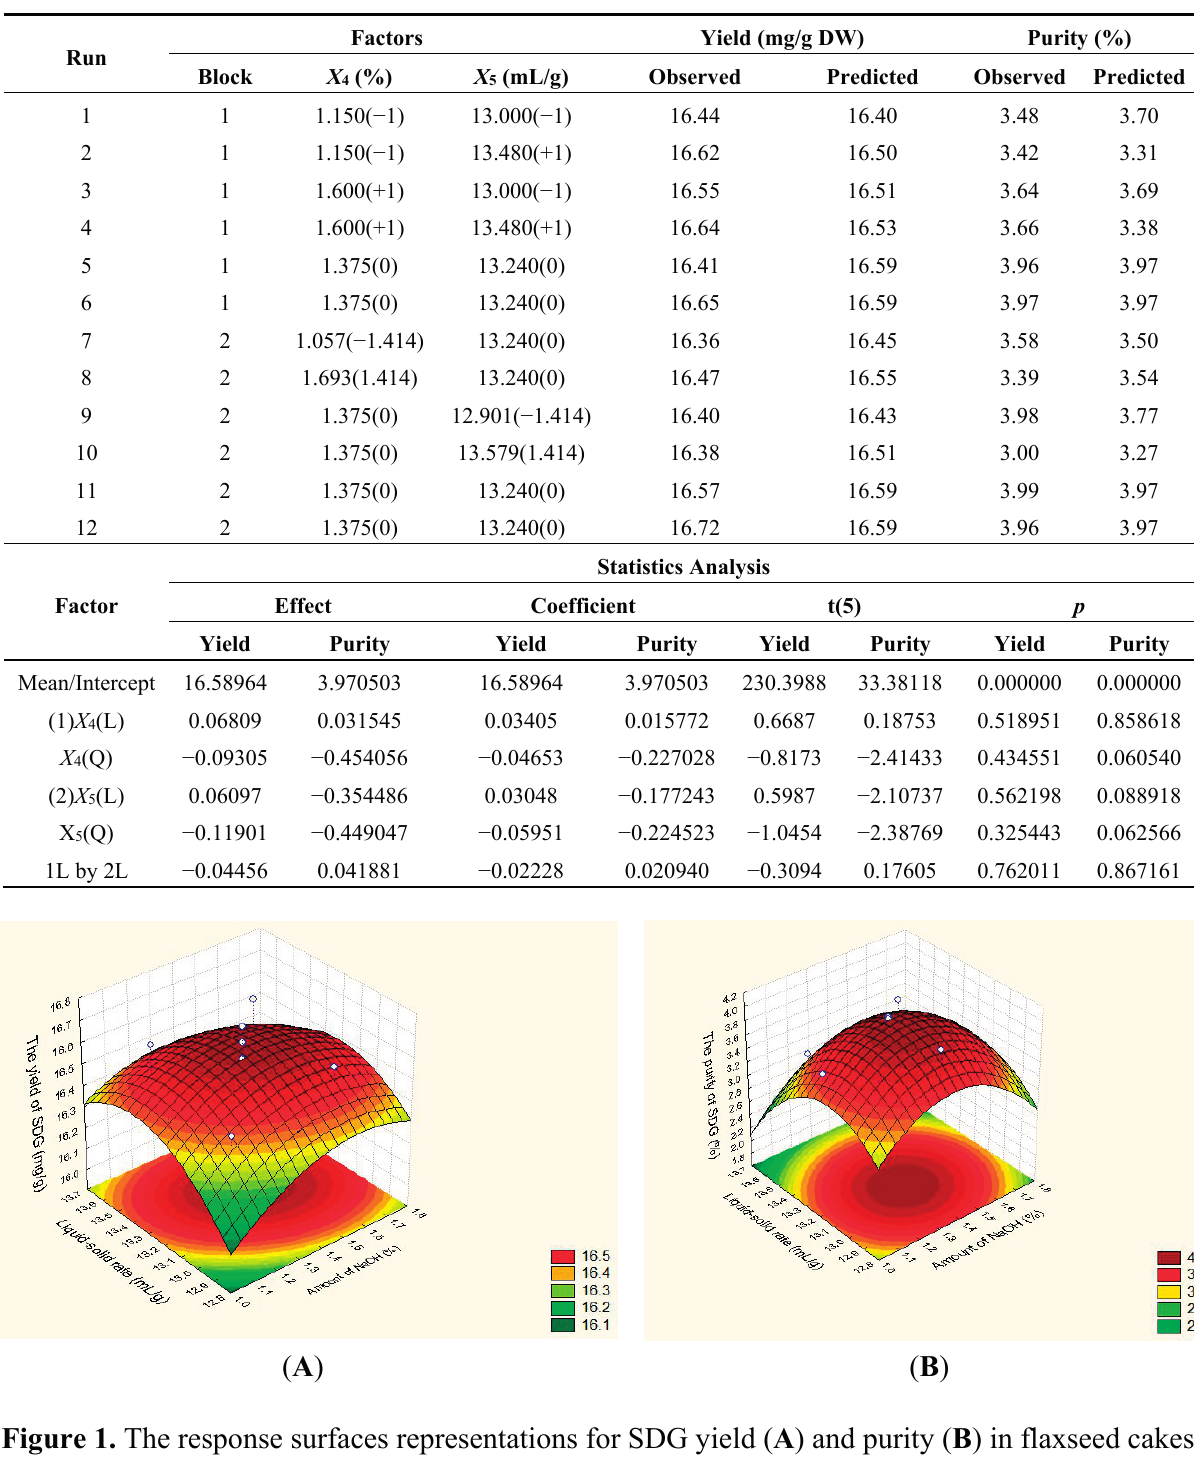
Table 2. The experiment design and results of central composite design (CCD) and the statistics analysis of SDG yield and purity.